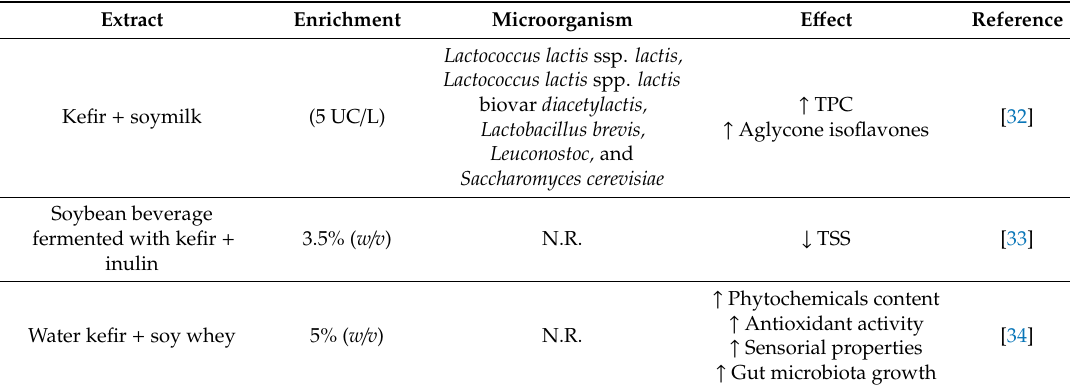
Table 2. Kefir fortification with soy-derived